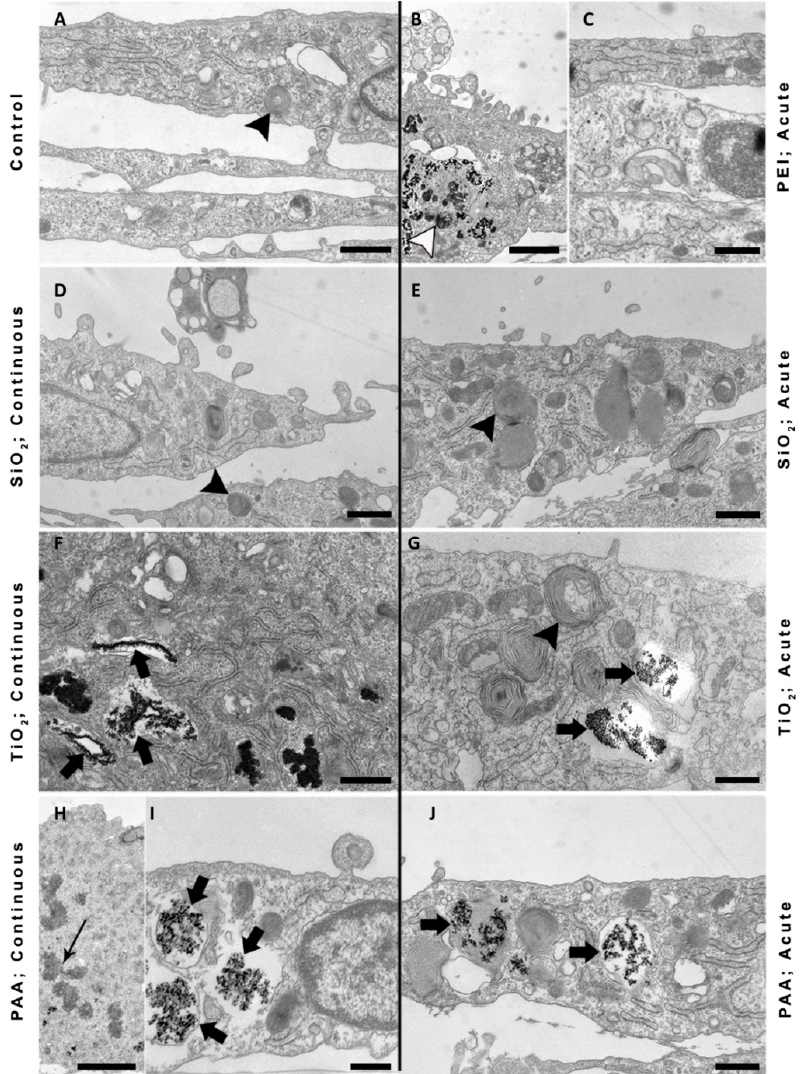
Figure 6. TEM images of L6 cells after prolonged exposure to NPs. Cells were exposed to ( A ) control; ( B , C ) PEI (2 μ g/mL) NPs, (acute exposure); ( D , E ) PAA NPs (continuous exposure); ( F ) PAA (acute exposure); ( G ), SiO 2 (continuous exposure); ( H ) SiO 2 (acute exposure); ( I ) TiO 2 (continuous exposure); ( J ) TiO 2 (acute exposure). Black arrowheads point to multilamellar bodies, open arrowhead points to amphisomes, long arrow points to chromosomes of the mitotic cell, short arrows point to endolysosomal compartments. Scale bars: 20 μ m.